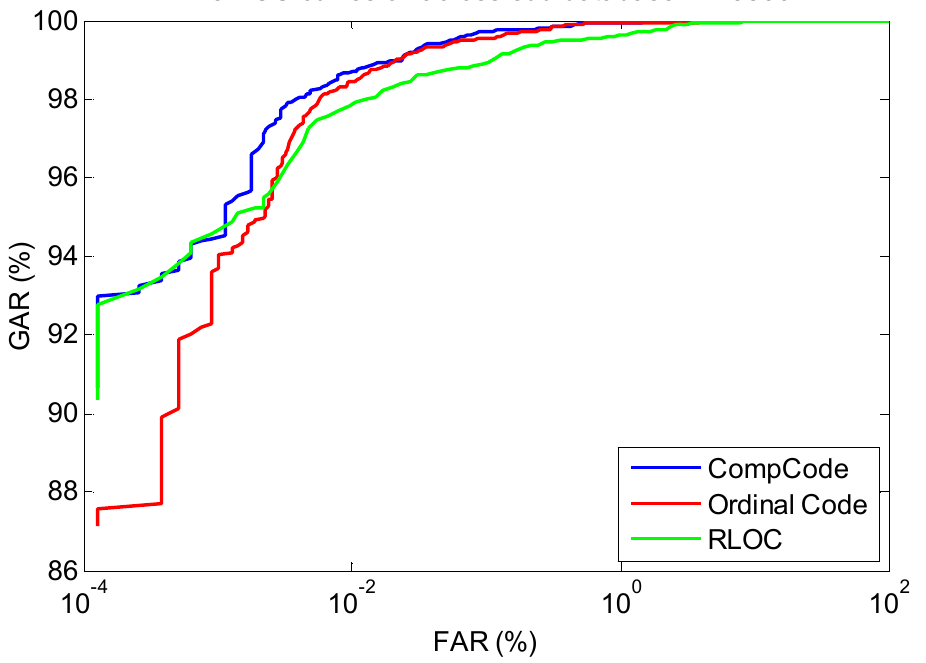
Figure 14. The ROC curves of methods Comp Code, Ordinal Code and RLOC on across-sub-database A_M525 (using the 1~3 samples of the first session as the training